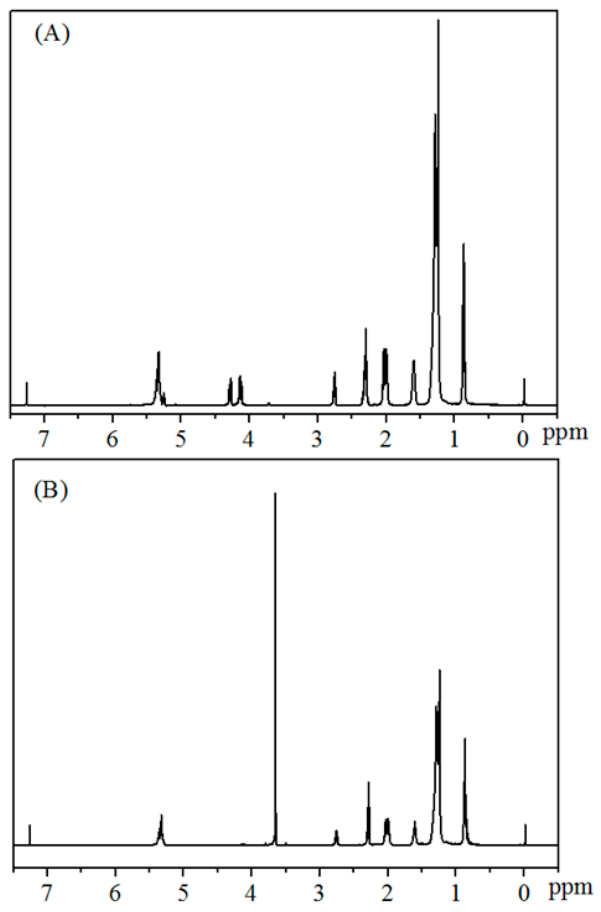
Figure 3. 1 H NMR spectra of the reaction mixtures for biodiesel production from ( A ) Jatropha oil, and ( B ) biodiesel.